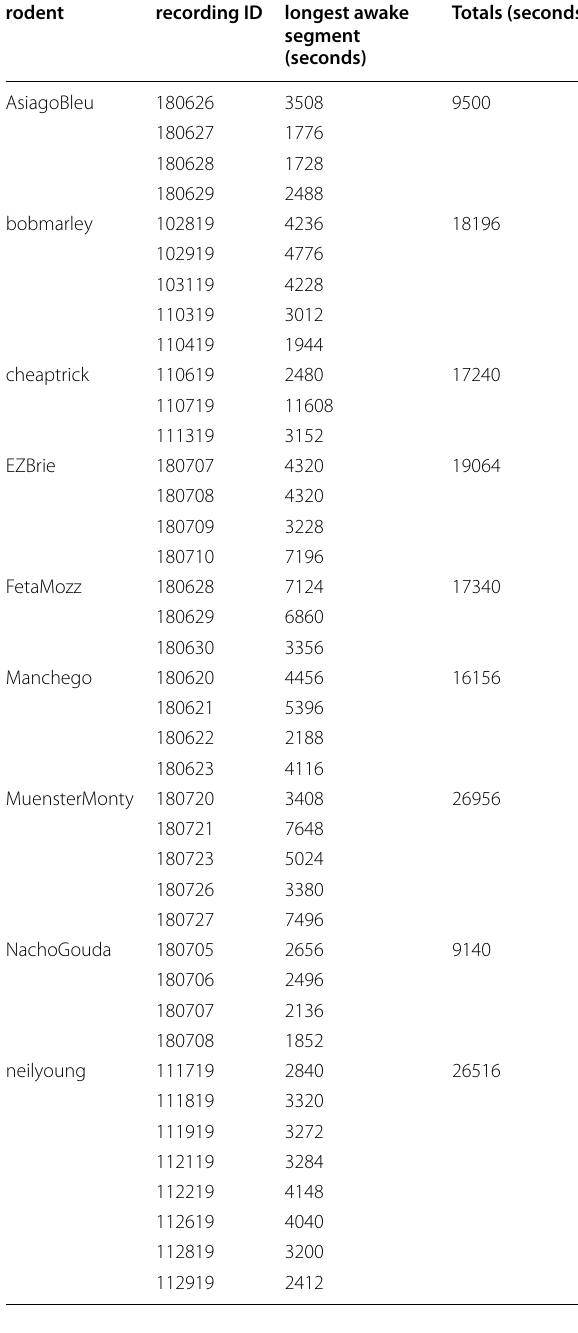
Table 3 Total time of awake segment per rodent of the data set